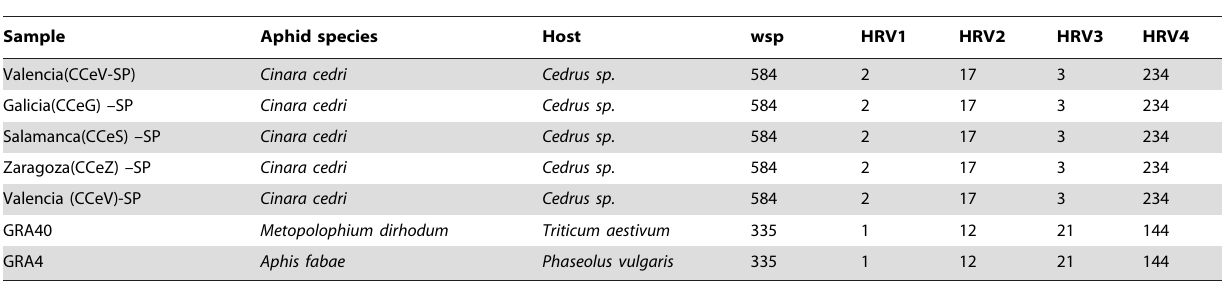
Table 3. Wolbachia WSP HVR profiles for aphid